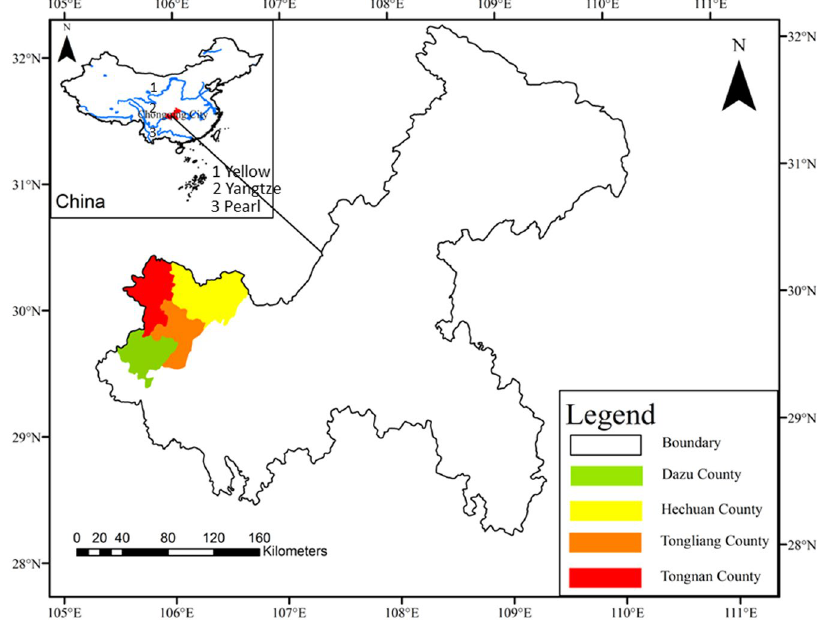
Figure 1. Location of sampling site in four Counties of the upper Yangtze (The data set is provided by Data Center for Resources and Environmental Sciences, Chinese Academy of Sciences (RESDC), http://www.resdc.cn; The data ArcMap 10.3 software is used to create Fig. 1 with Figure legends, and the software can be accessible via the link https://blogs.esri.com/esri/arcgis/2014/12/10/arcgis-10-3-the-next-generation-of-gis-is-here/).